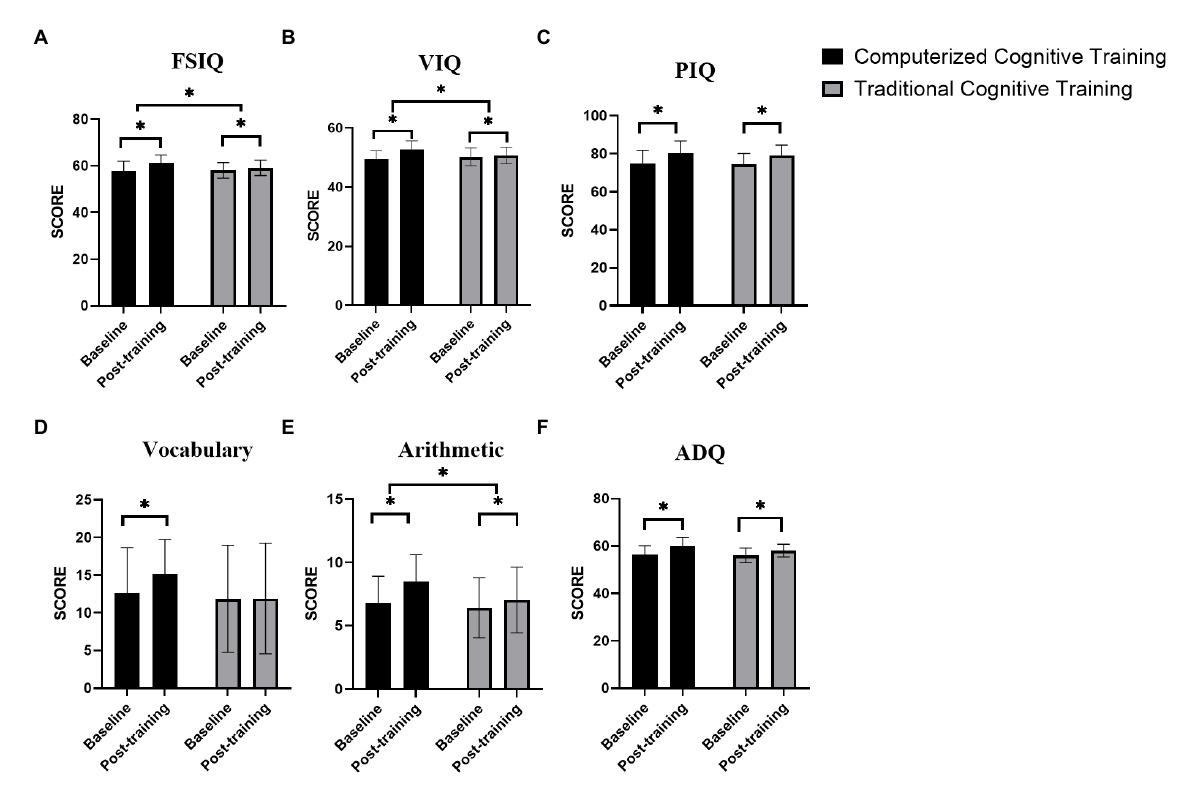
FIGURE 3 Within-group comparisons of (A) FSIQ, (B) VIQ, (C) PIQ, (D) arithmetic, (E) vocabulary, and (F) adaptive functioning scores for the baseline and post-training assessment occasions. Horizontal lines indicate significant post hoc comparisons with paired t-tests (* p ≤ 0.05, two-tailed). Significant group × time interaction effects were found in FSIQ, VIQ, and arithmetic.